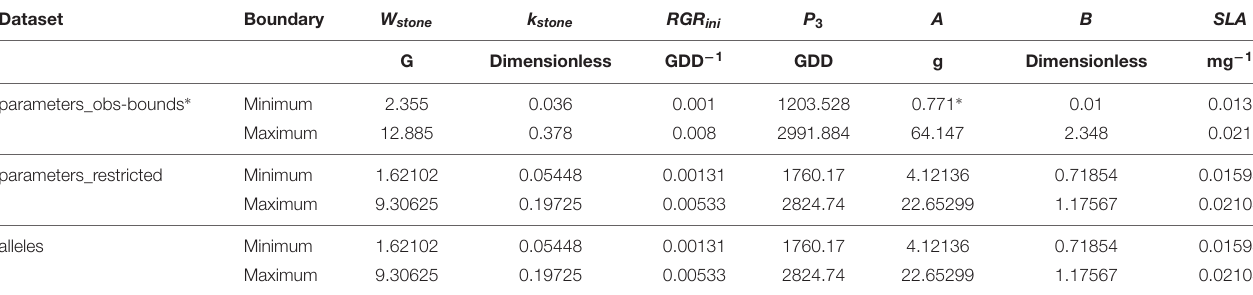
TABLE 4 | Values of the boundaries of the parameter spaces and the allele space for the seven